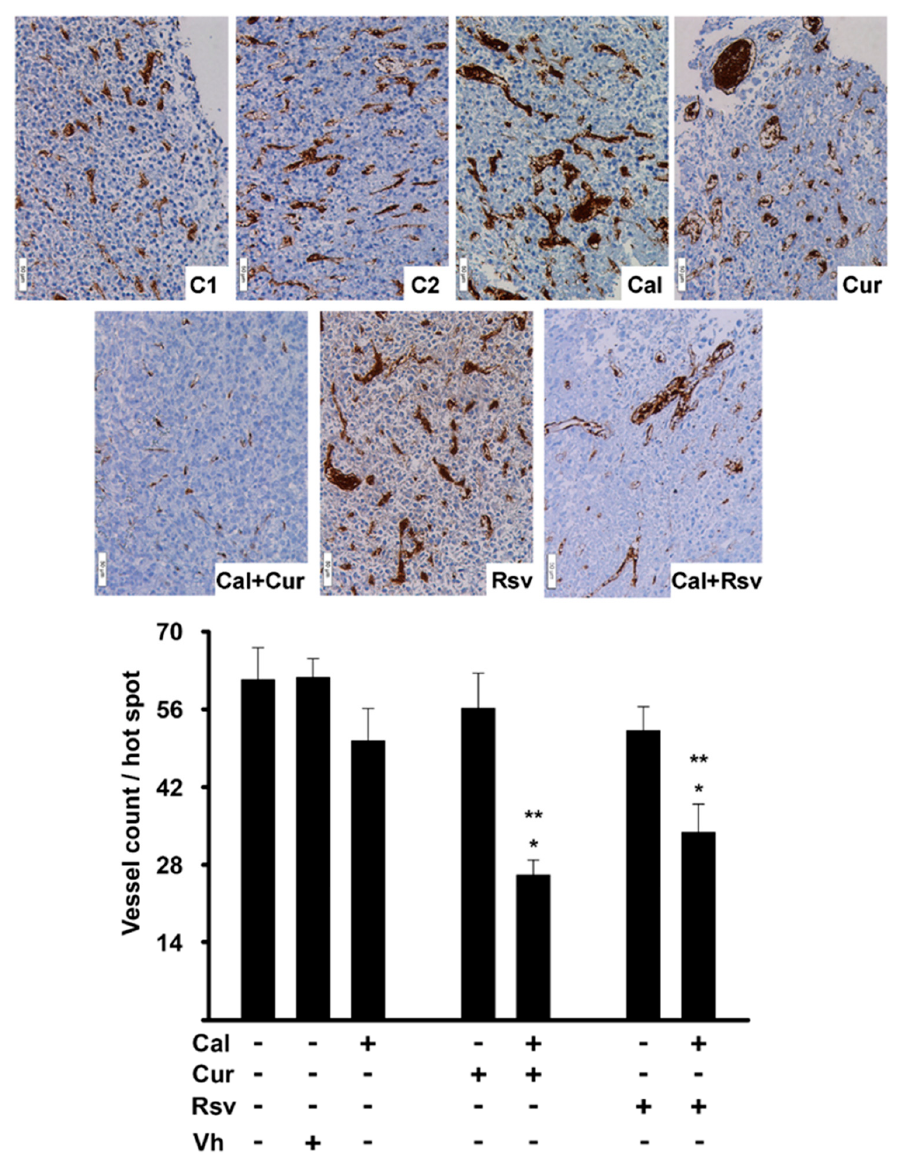
Figure 5. In vivo, the co-treatment of calcitriol with curcumin or resveratrol reduced vessel density and diameter. Itgb3 immunohistochemistry (brown staining) was used to identify and count vessels in the tumor tissue of mice treated with: saline solution (C1), vehicle (C2), calcitriol (Cal), curcumin (Cur), resveratrol (Rsv), or the co-treatment of calcitriol with curcumin or resveratrol (Cal + Cur or Cal + Rsv, respectively). Representative images are shown in the upper panel; magnification 20 × , scale bar indicates 50 µ m. In the lower panel, vessel count results are depicted as the mean ± SEM. Three hot spots per tumor were counted in at least 10 di ff erent tumors per treatment by three di ff erent observers. * p < 0.001 vs. control groups, ** p < 0.05 vs. each compound